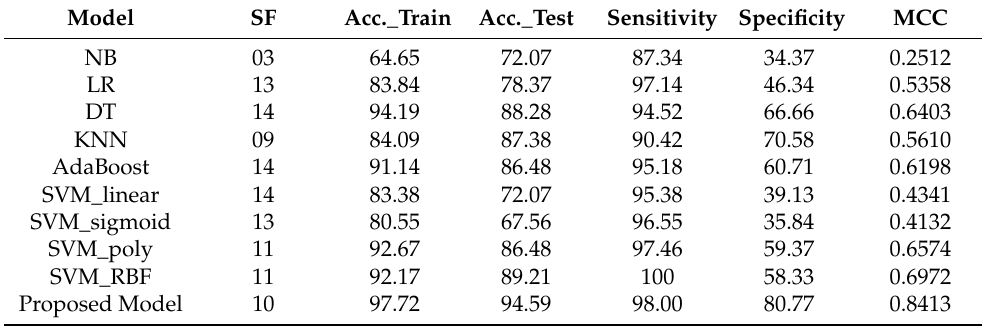
Table 6. Performances of ML models on balanced data using the χ 2 feature selection.